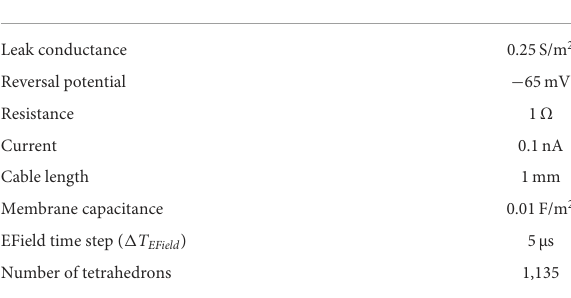
TABLE 1 Parameters for rallpack